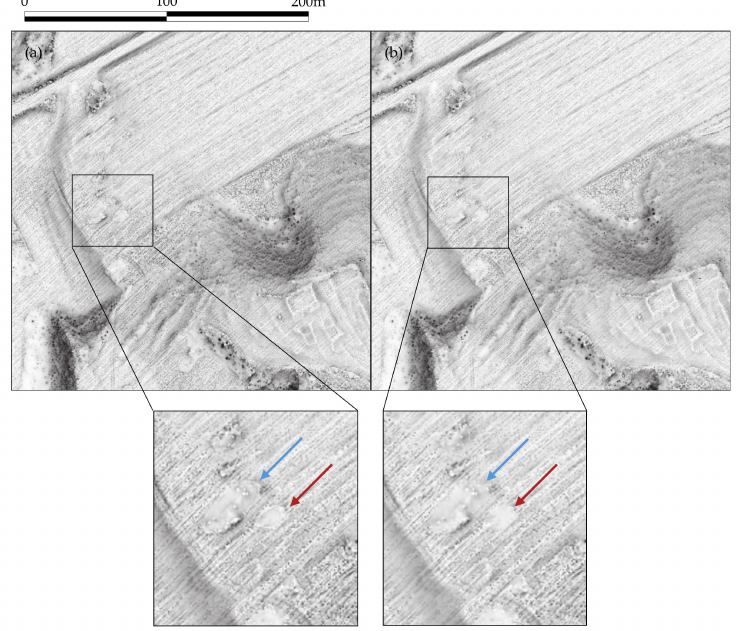
Figure 11. Test site SI2, examples of donut-shaped interpolation artifacts that occur where areas with DFM confidence map level one border directly with level four or higher. Donut-shaped artifacts are avoided by adjusting the “Grow radius” setting: ( a ) grow radius 0; ( b ) grow radius 3. DFM processing: hybrid interpolator, other processing steps as in Table